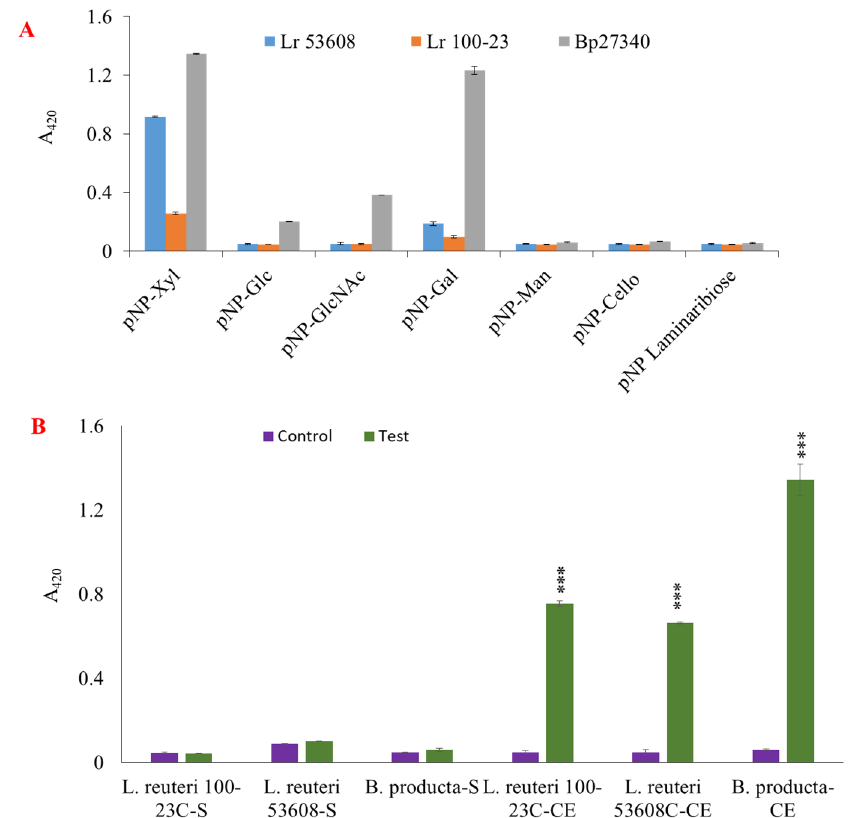
Figure 2. Enzymatic activity of L. reuteri and B. producta strains grown on XOS. The enzymatic activity of bacterial cell lysates from L. reuteri ATCC 53608 (Lr 53608), L. reuteri ATCC 100-23C (Lr 100-23), and B. producta ATCC 27340 (Bp27340) was determined using the artificial substrates p NP-Xyl, p NP-Glc, p NP-Cello, p NP-GlcNAc, p NP-Gal, p NP-Man, and p NP-laminaribiose ( A ). Cell extract (CE) and bacterial supernatant (S) were used to determine enzymatic activity using p NP-Xyl ( B ) as a substrate (2 mM final concentration). The results are representative of three replicates, and differences between control and test were analyzed by two-way ANOVA and Bonferroni post-tests (*** p = 0.001).